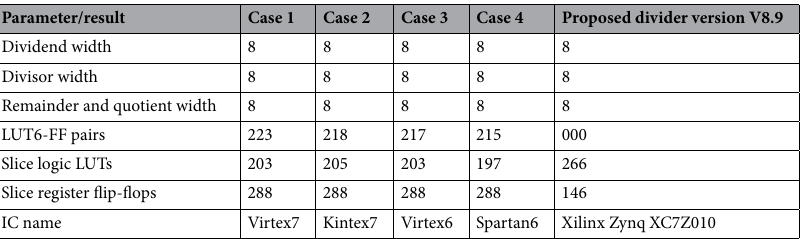
Table 5. Comparative analysis regarding the resource utilization of the proposed USP-Awadhoot algorithm- based divider and Xilinx’s LogiCORE IP divider generator